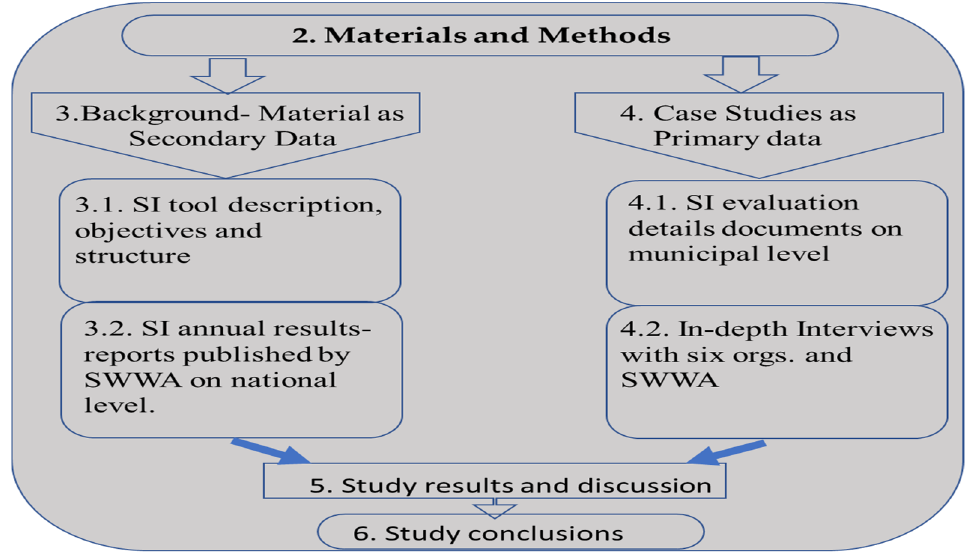
Figure 1. Methodological structure of the study .